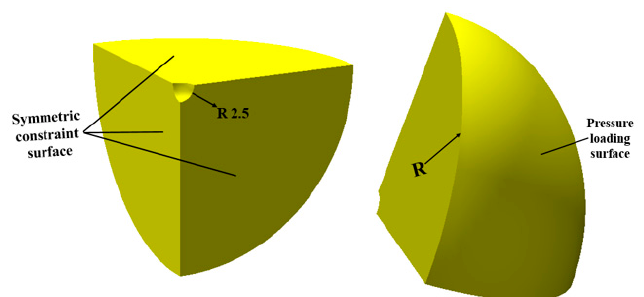
Figure 5. The FE model of steel ball.